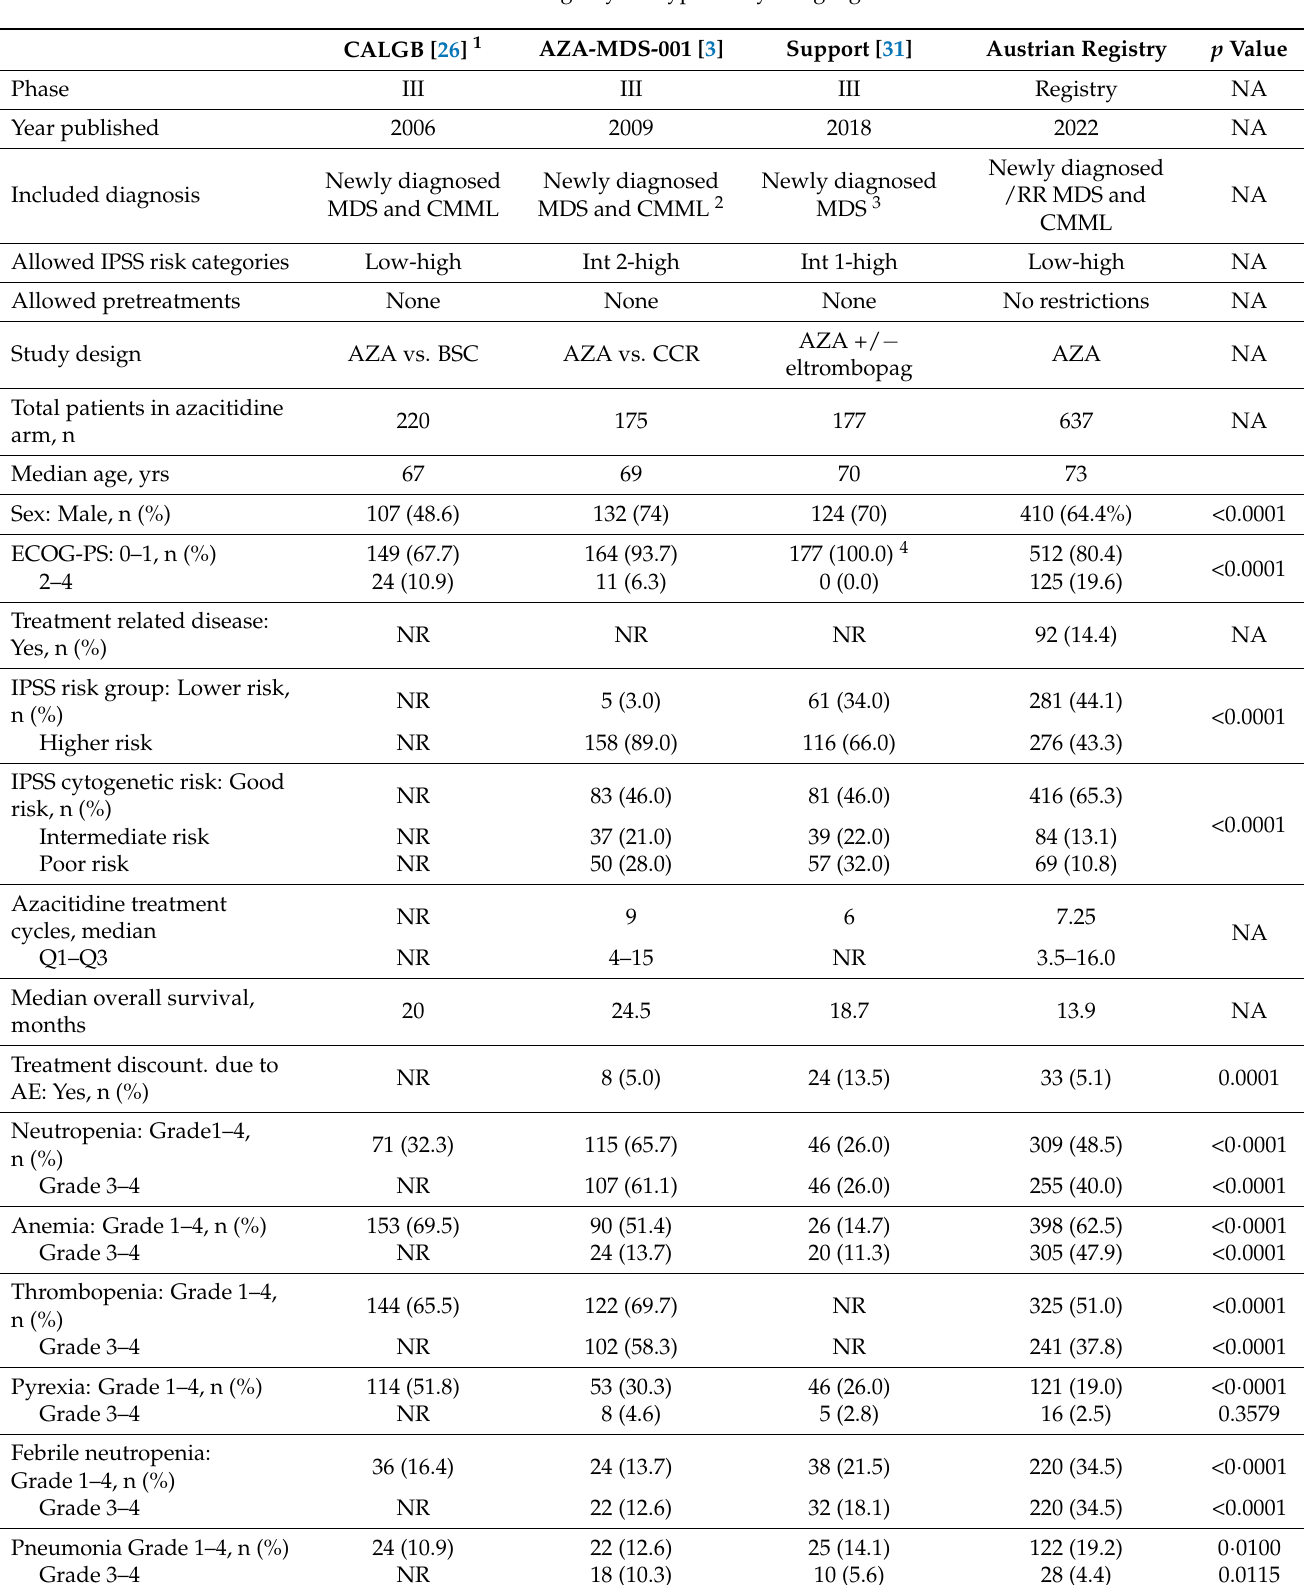
Table 3. Comparison of adverse events that occurred in patients with myelodysplastic syndromes or chronic myelomonocytic leukemia treated with azacitidine monotherapy within phase III clinical trials or the Austrian Registry of Hypomethylating